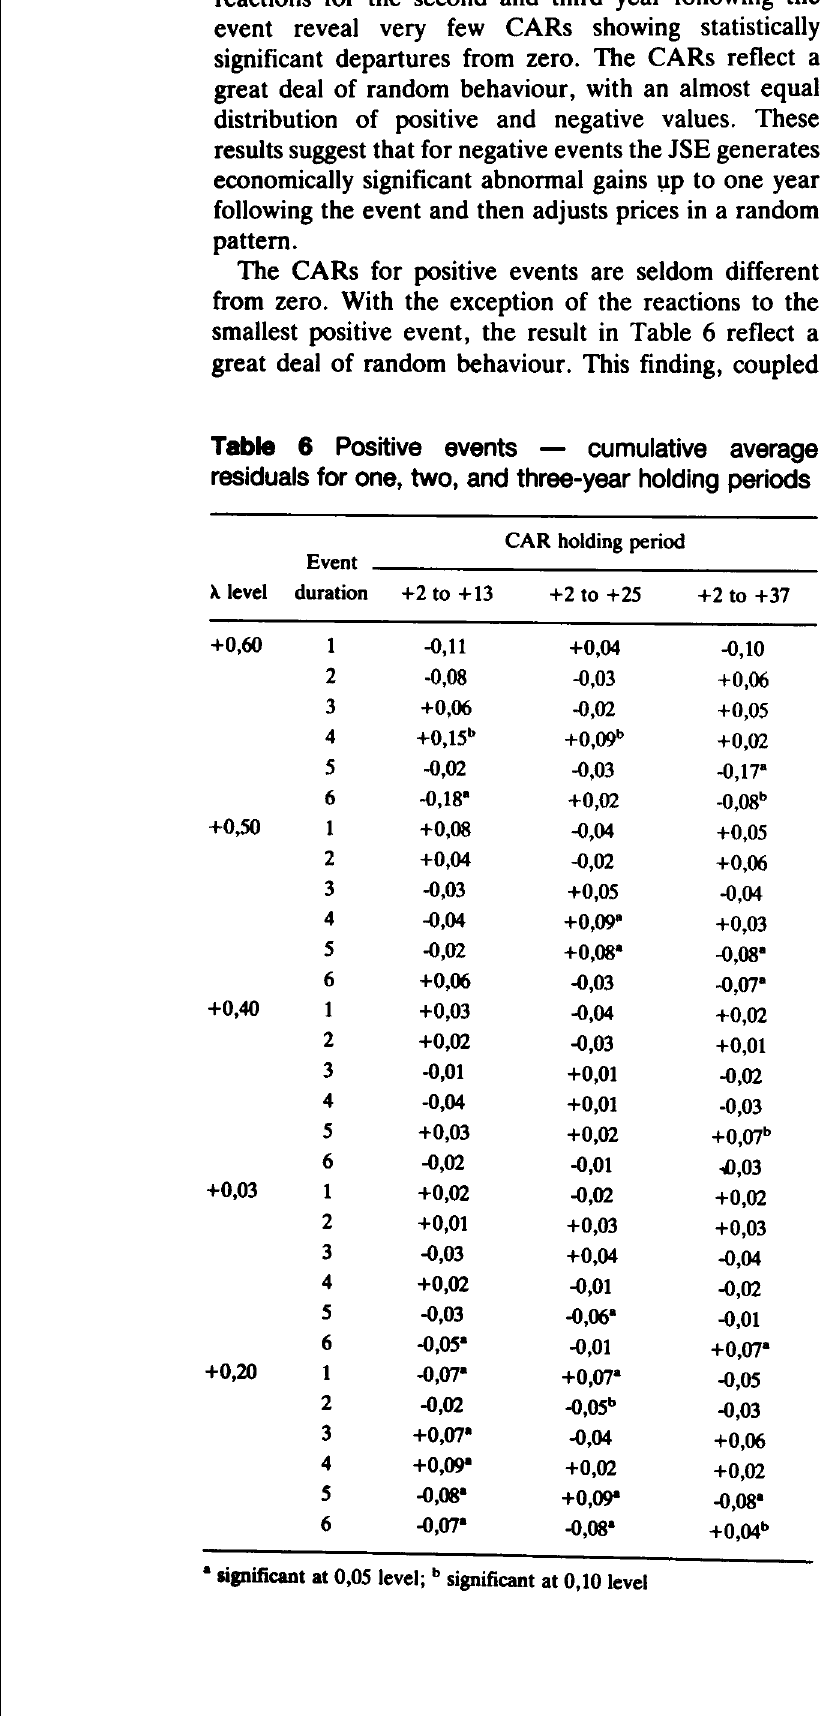
residuals for one, two, and three-year holding periods